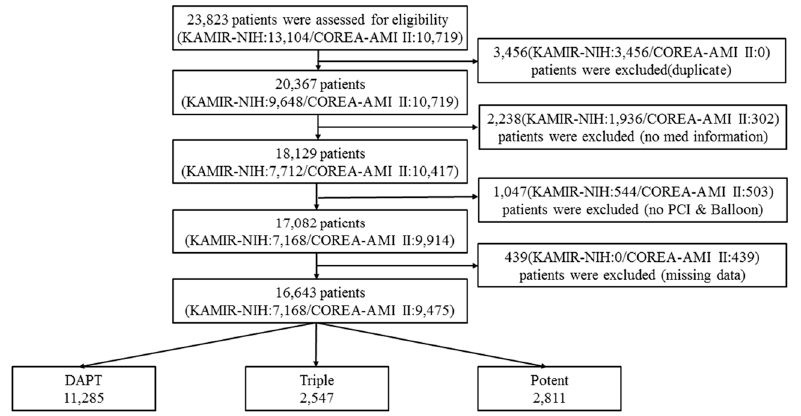
Figure 1. Flowchart of patients enrolled in the study.